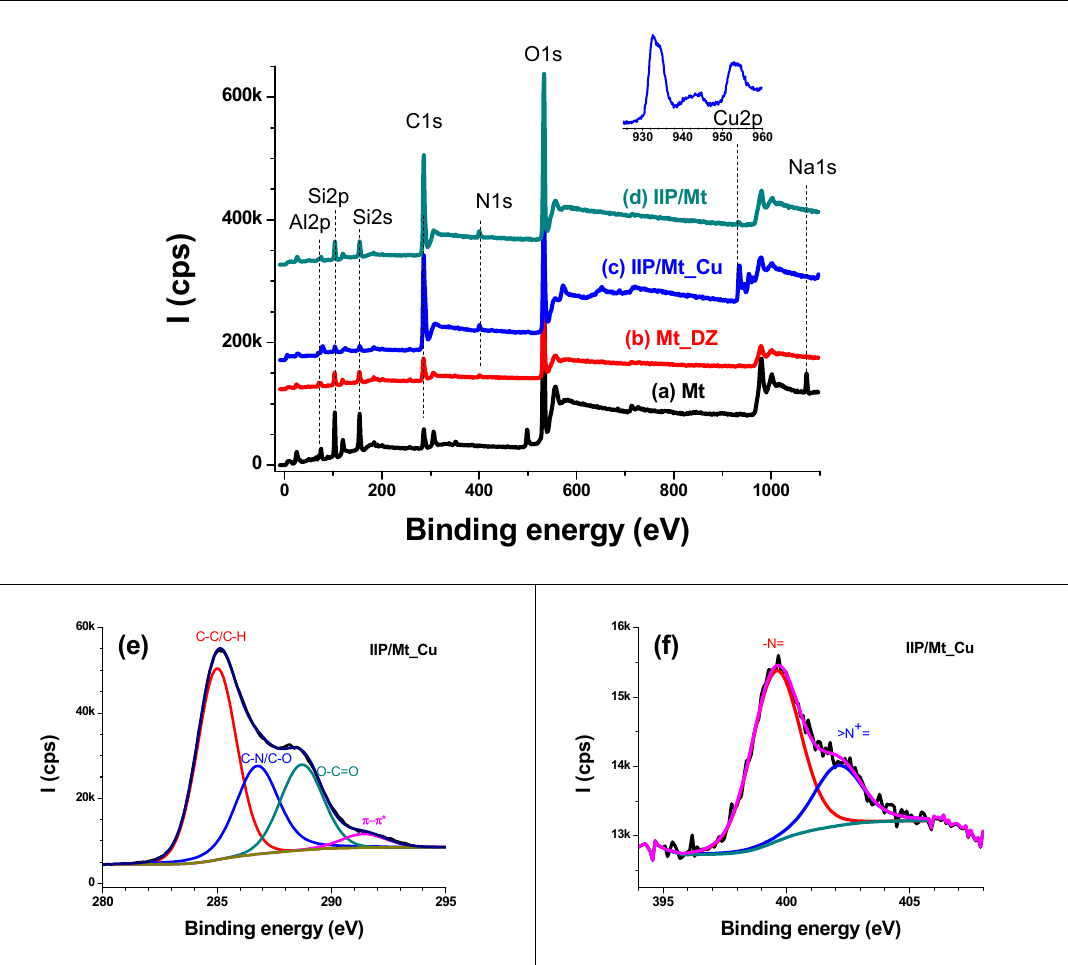
Figure 3. XPS analysis of Mt, Mt_DZ and IIP/Mt_Cu (before extraction of copper) and IIP/Mt (after extraction of copper). Survey regions: ( a – d ), peak-fitted C1s and N1s narrow regions of IIP/Mt_Cu: ( e , f ), respectively.